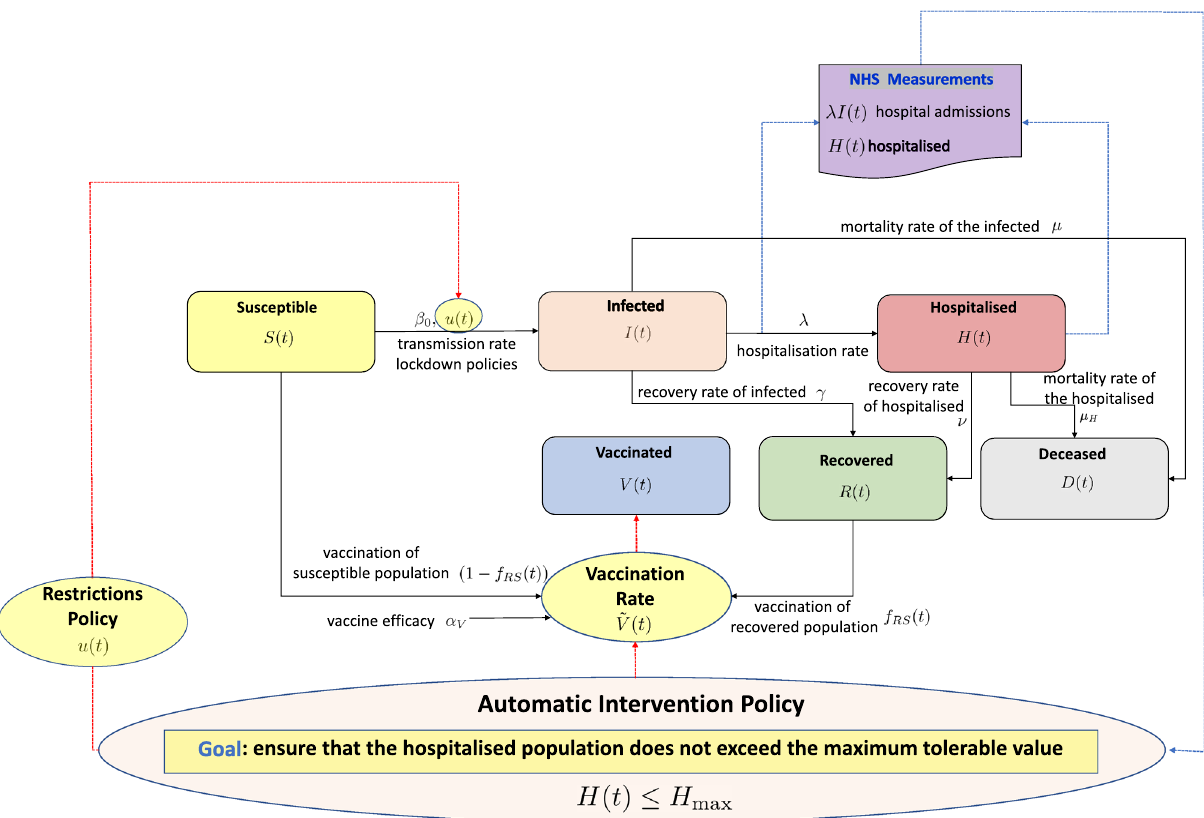
Figure 1. A schematic of the adopted compartmental SIHRD-V epidemiological model The directions of the arrows indicate a positive influence on the considered signal. The blue dashed line indicates the NHS measurements, whilst the red dashed lines the interventions